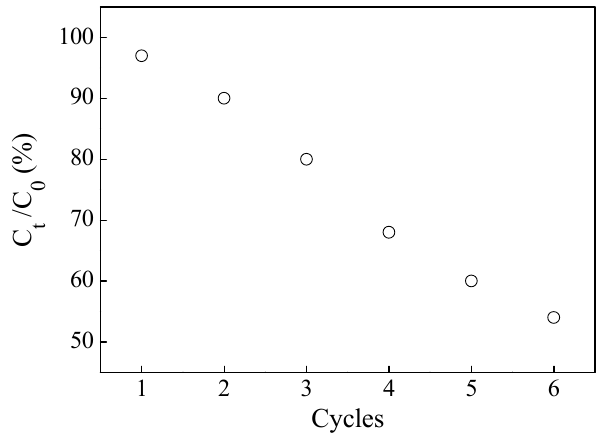
Figure 10. Removal efficiency of FeSiB AR reacting with Pb(II) solutions for six 90 min cycles.